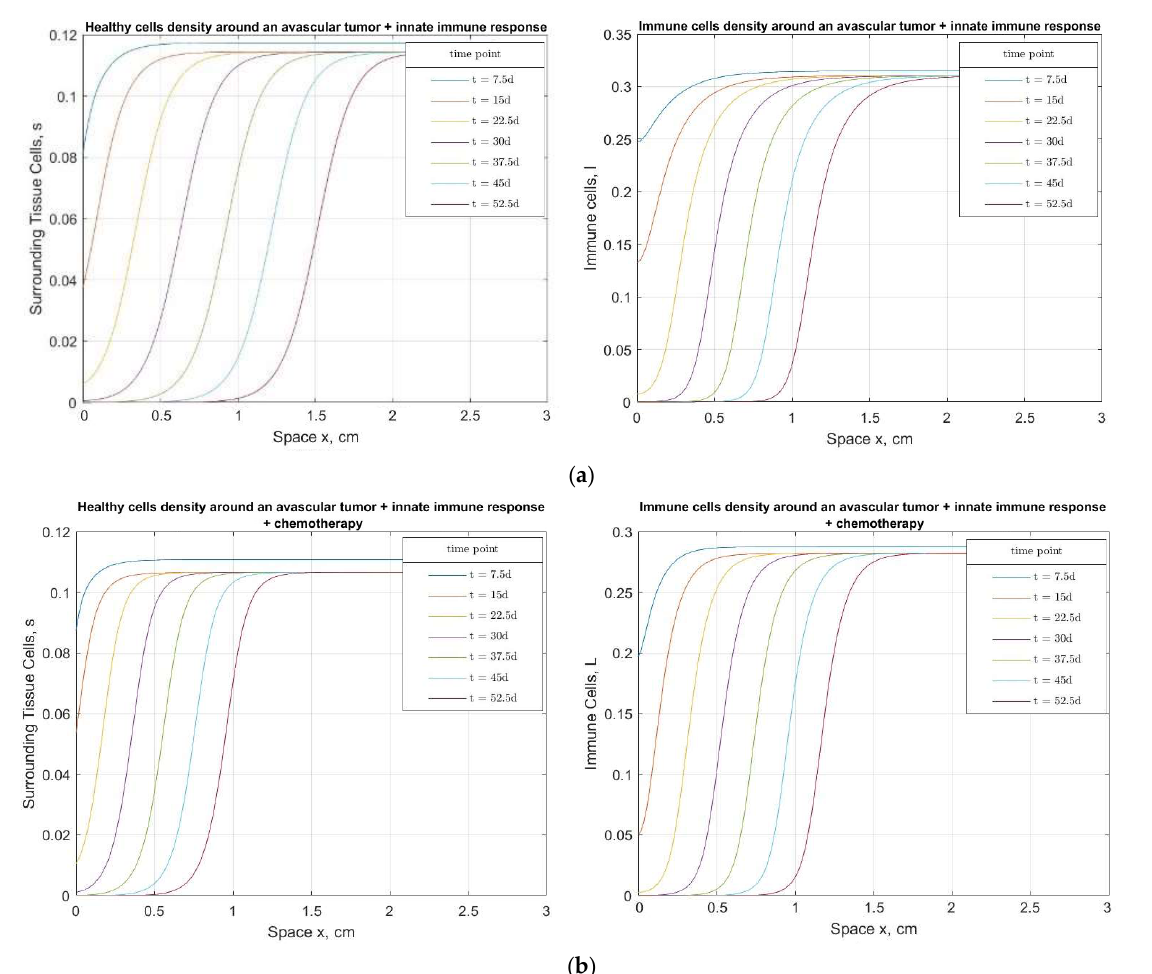
Figure 4. Numerical solutions of surrounding healthy and immune cell densities ( a ) before the drug intake, ( b ) under the effect of chemotherapy, as functions of space x at times t = 0…52.5 days.